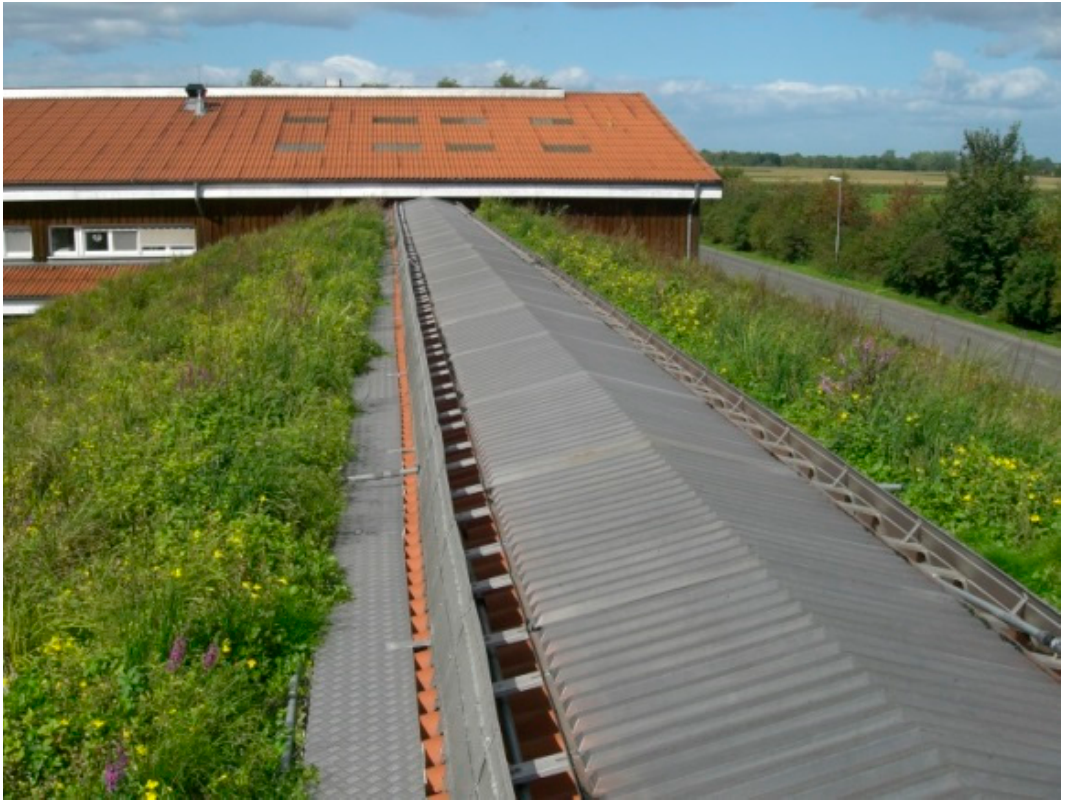
Figure 6. Wetland roof on a cow barn of the Federal Research Institute for Agriculture (FAL) in Braunschweig, Germany (roof surface 834 m², photo: Michael Blumberg) .